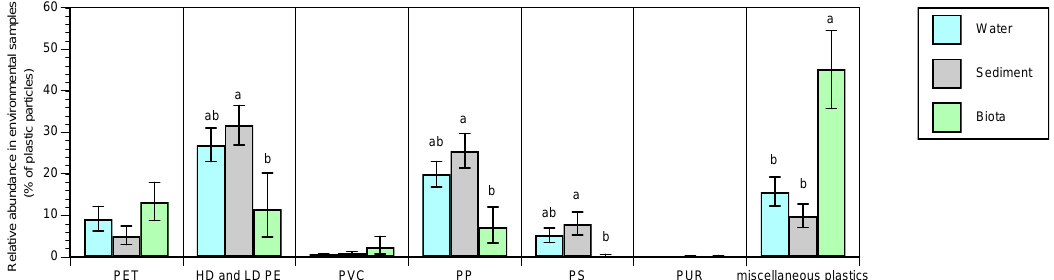
Figure 5. Mean relative abundance of polymers (% of particles ± SE) reported as microplastics in water (n = 39), sediment (n = 23) and biota (n = 10) sampled in freshwaters and estuaries. Influence of matrix (water, sediment or biota) p = 0.0362 from MANOVA. Significant differences within polymers were identified by Tukey’s test, where mean values that are not significantly di ff erent (within polymers)